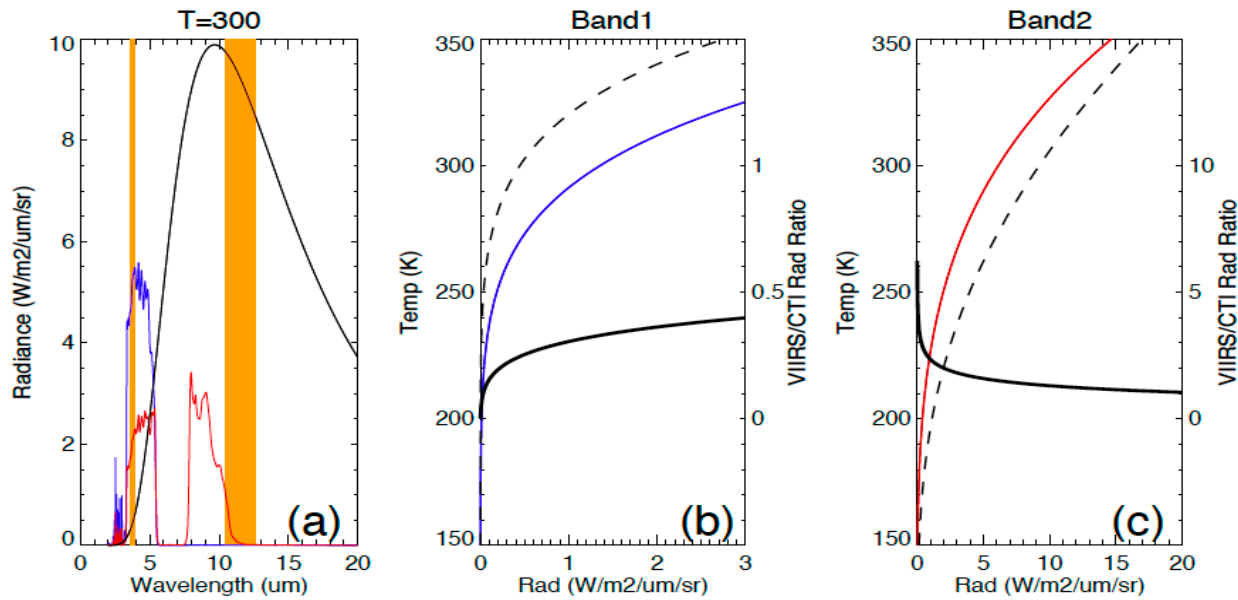
Figure A7. ( a ) CTI band1 (blue) and band2 (red) spectral response functions and VIIRS I4 (center = 3.75 µm, bandwidth = 0.4 µm) and I5 (center = 11.45 µm, bandwidth = 1.9 µm) bands in orange with a Planck function from the 300 K emission; ( b ) calculated CTI band1 (blue) and VIIRS I4 (dashed) radiances from different temperatures and their radiance ratio (black); ( c ) calculated CTI band2 (red) and VIIRS I4 (dashed) radiances from different temperatures and their radiance ratio (black).